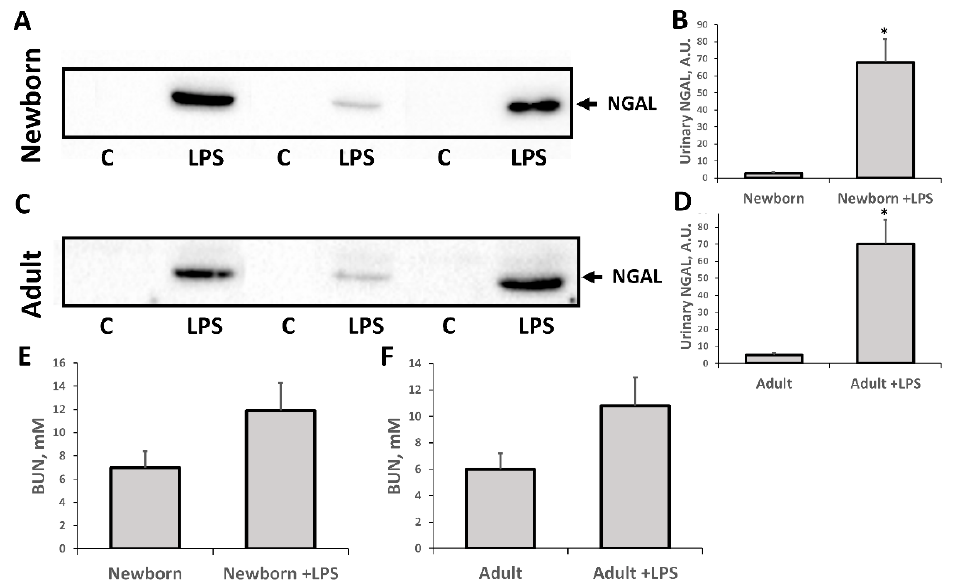
Figure 4. Acute kidney injury in ( A , B , E ) neonatal rats and ( C , D , F ) adult rats 24 h after LPS treatment. Significant increase in urinary neutrophil gelatinase-associated lipocalin 2 (NGAL) content and some rise of blood urea nitrogen (BUN) was observed. Diagrams on B, D represent densitometry analysis of corresponding bands on the blots. Number of animals for western blot densitometry: Adult ( n = 4), Newborn ( n = 4), Adult + LPS ( n = 4), Newborn + LPS ( n = 4). *: p < 0.05.